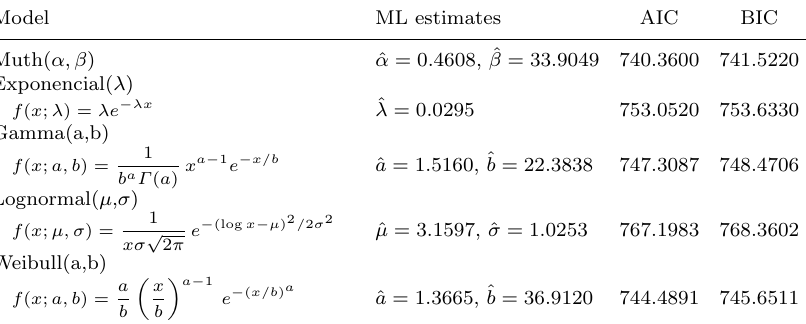
Table 7. Carrol data set: Model, ML estimates, AIC and BIC values.